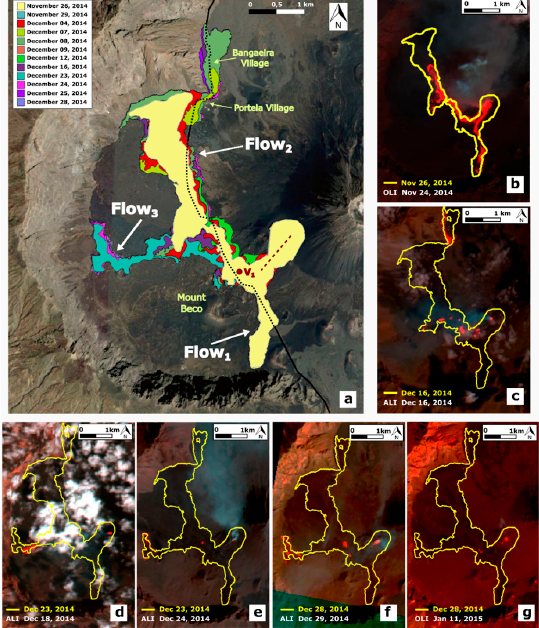
Figure 2. ( a ) Map displaying the most important stages of growth of the lava flow field. The legend shows in different colors the stages of growth of the lava flow field, as well as the eruptive fissure (red dotted line), Mount Beco, Portela, Bangaeira, Vent 1, and the names of the three arterial flows: Flow 1, Flow 2, and Flow 3. ( b – g ) Satellite images showing in red the active portion of the lava flow field, with the outline of the lava flow field in yellow. The destroyed (dotted black line) and residual portion (black line) of the access road to the Cha Caldera is also shown.